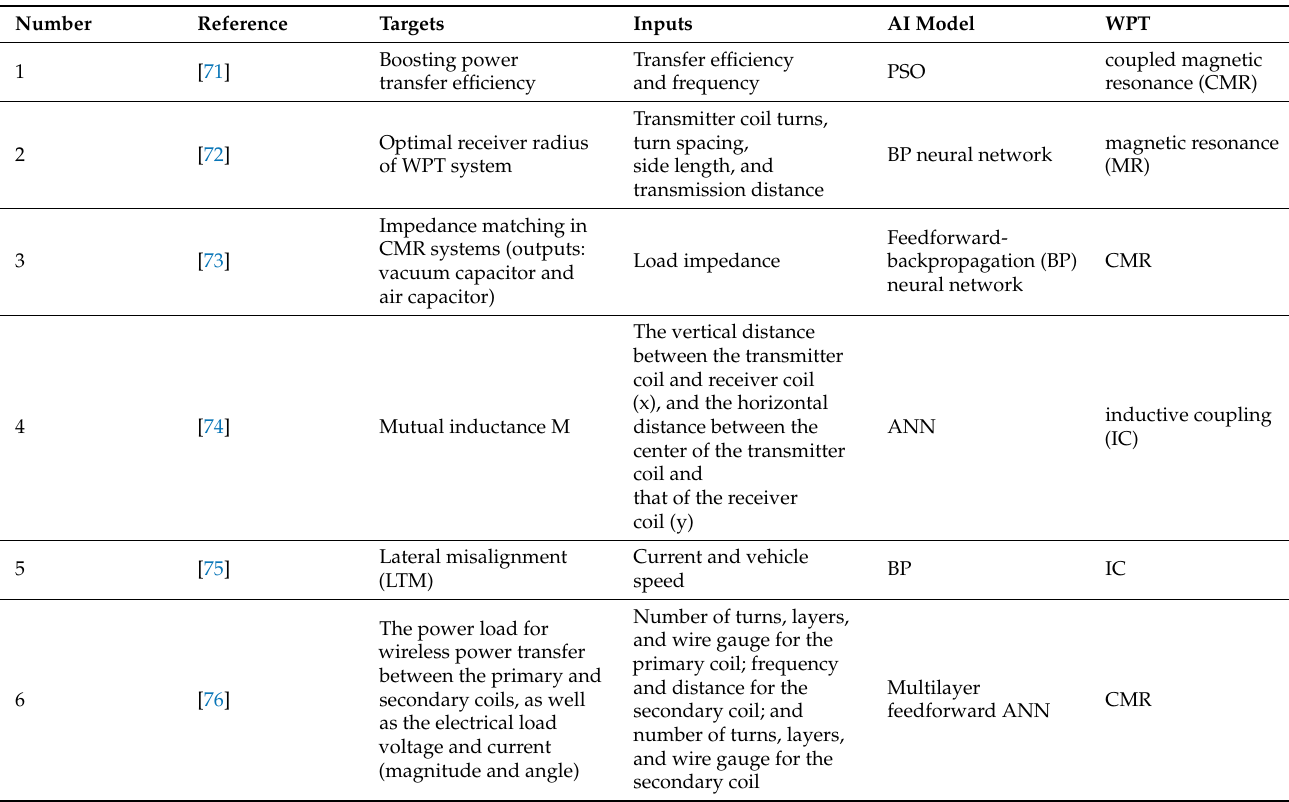
Table 6. Literature review on applications of AI for